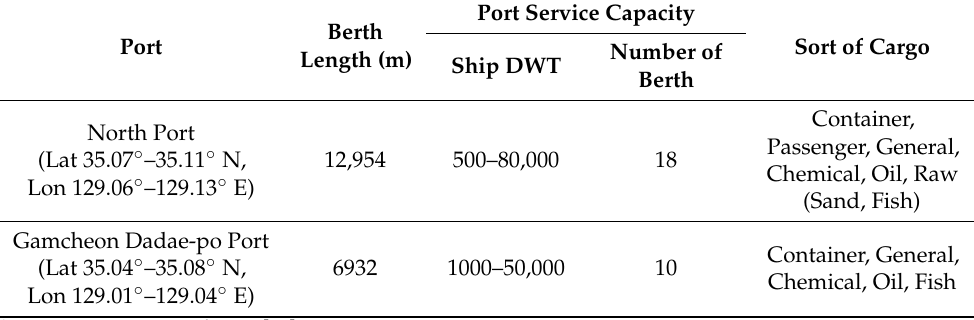
Table 1. Details of the capacity of Busan